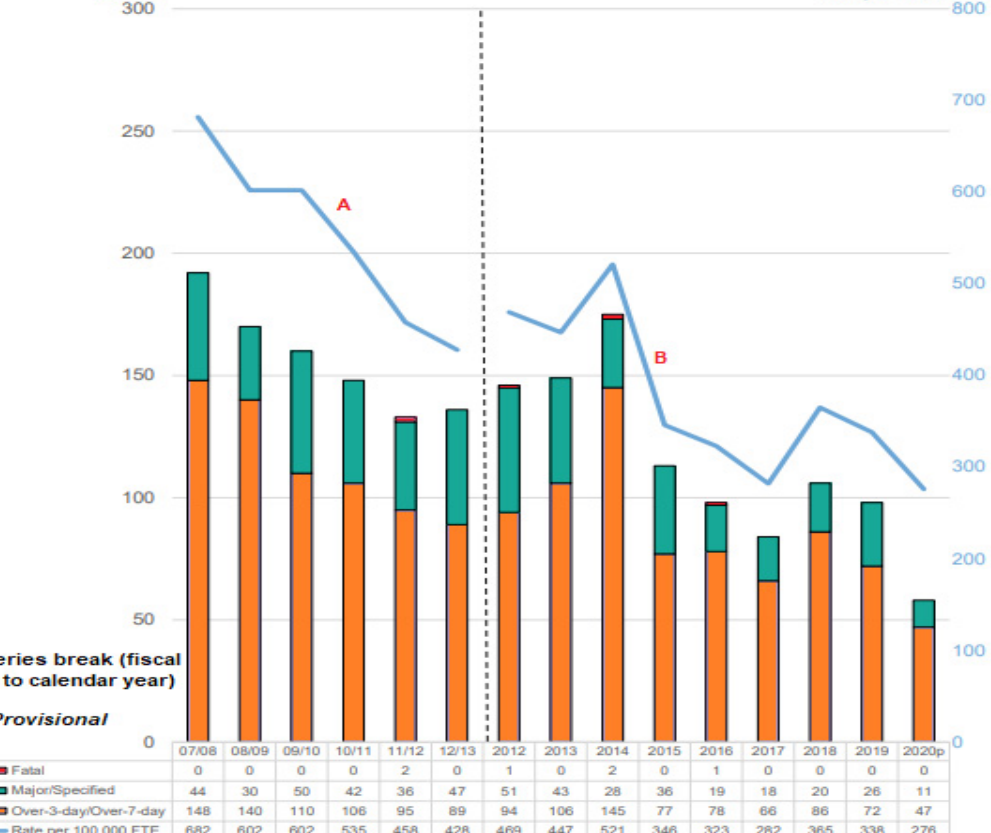
Figure 3. Oil and gas offshore injury rate showing fatal injuries, over 3 days/over 7 days, major injuries, and rate per 100,000 FTE for all reported offshore injuries, from 2007/08 to 2020 using RIDDOR database for full time equivalent (FTE) workers. Note: A and B show two different accident reporting styles by years, such as 12/13 and 2014. (This image is re-used/reproduced with permission of the Health and Safety Executive under the terms of the Open Government License, Courtesy: HSE, UK. Source: RIDDOR and HSE [190]).